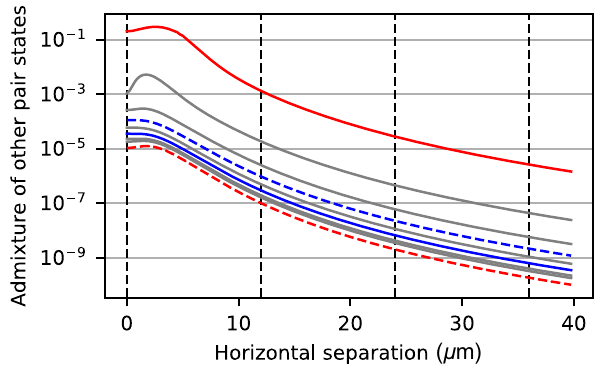
FIG. 10. Admixture of other pair states P (cid:18)( n ) into the pair | a , nC (cid:3) for n = 56–66. The computational states are color-coded following Fig. 1(a), and the others are shown in gray. The horizontal lines show lattice sites with a circ = 12 μ